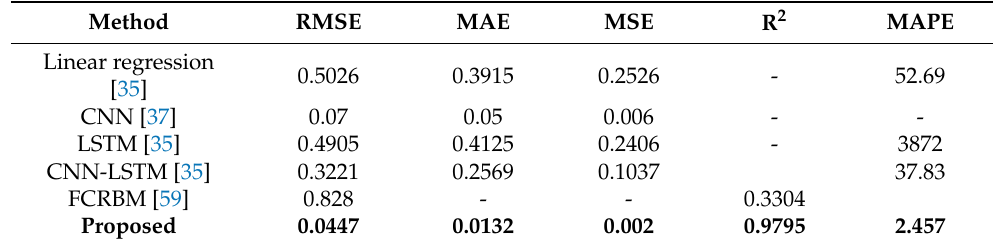
Table 4. Performance comparison of R-CNN and ML-LSTM with state-of-the-art over daily IHEPC dataset.